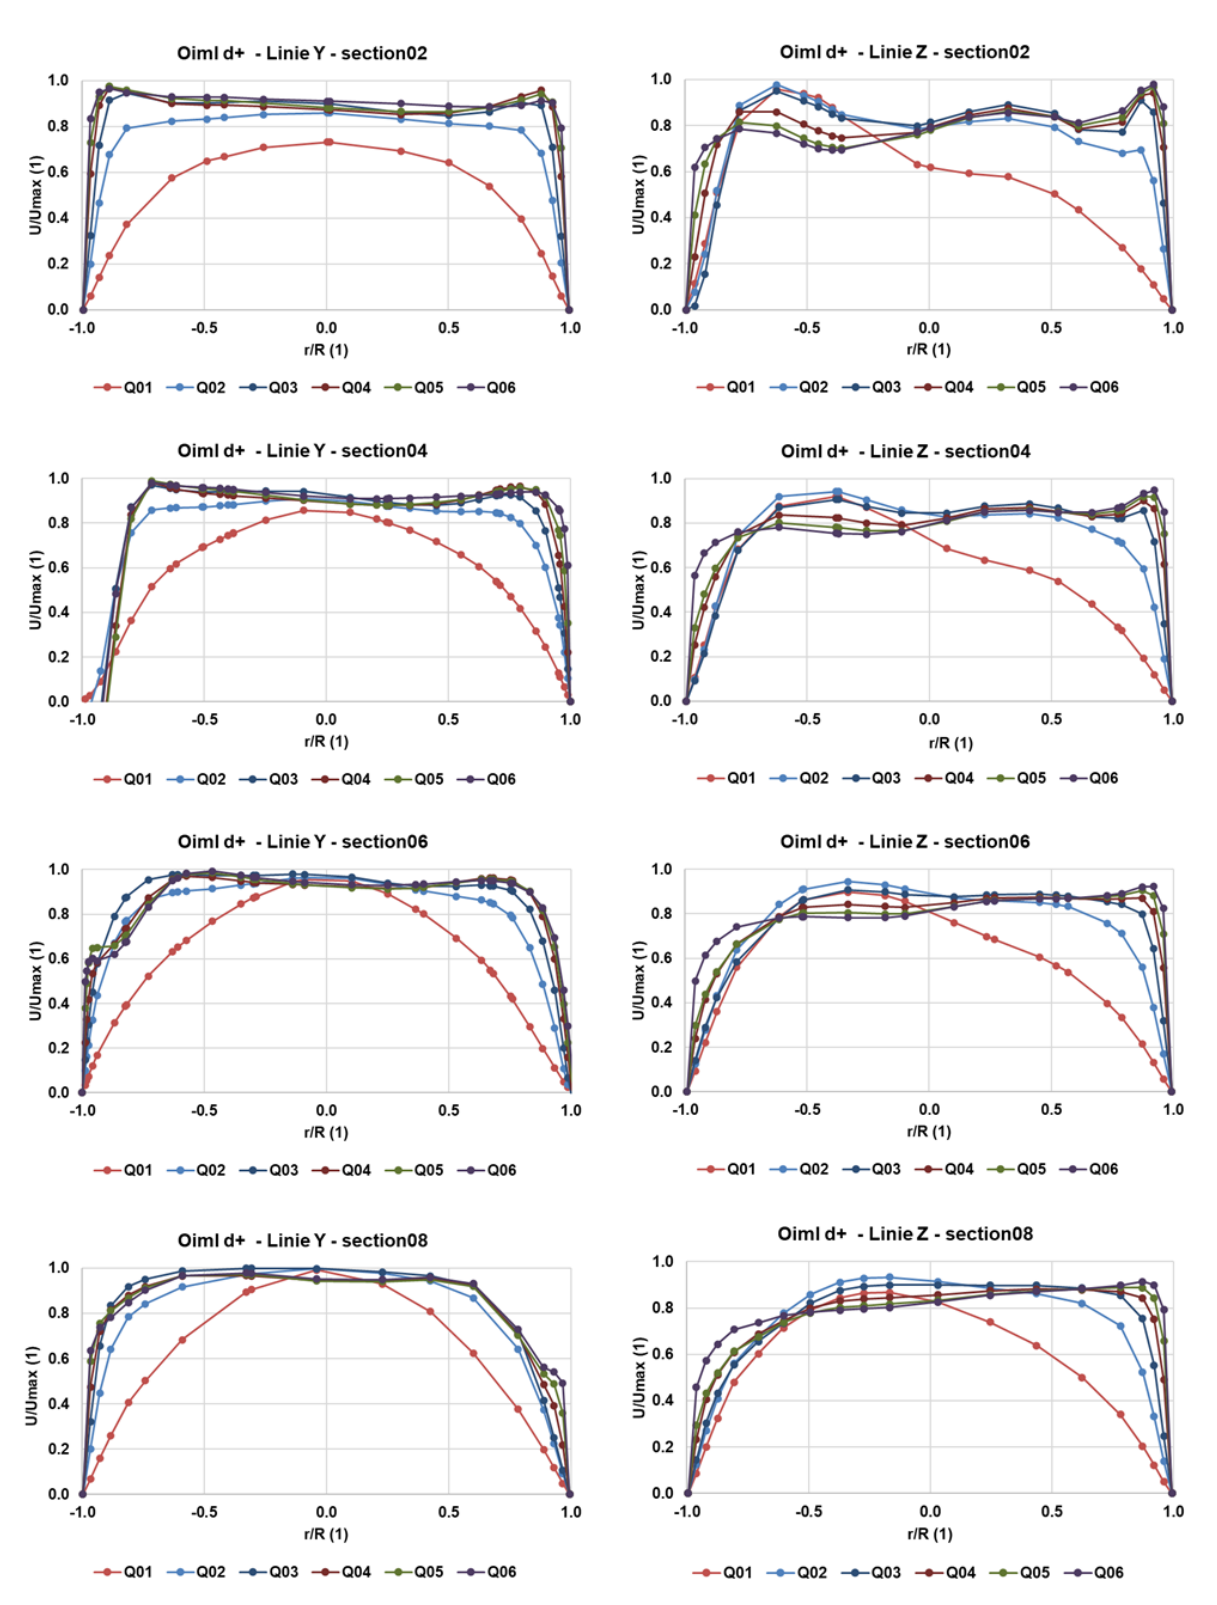
Fig. 7 Velocity profiles – straight pipe (no disturbance), selected